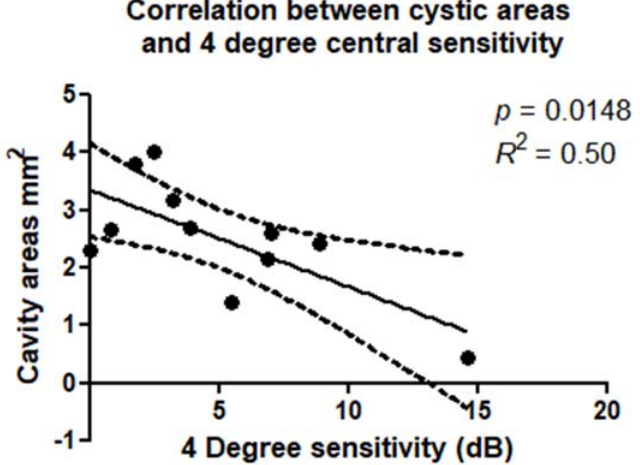
Figure 7. Scatterplot shows the statistically significant correlation ( p = 0.0148; R 2 = 0.50) between cavity areas on OPL + HFL complex (mm 2 ) and microperimetry 4 degree sensitivity (dB).